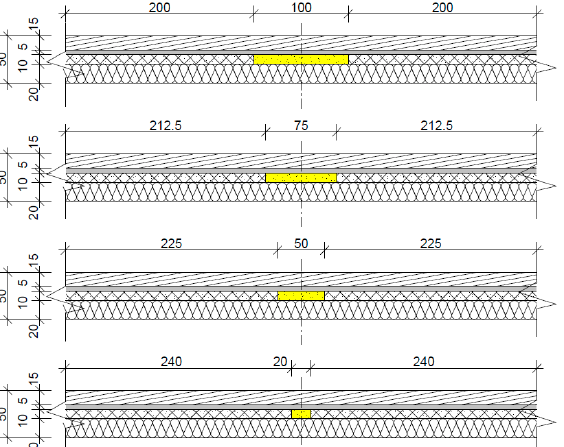
Figure 4. Diagram of a 50 mm thick panel with a PUR joint of 20–100 mm (yellow).